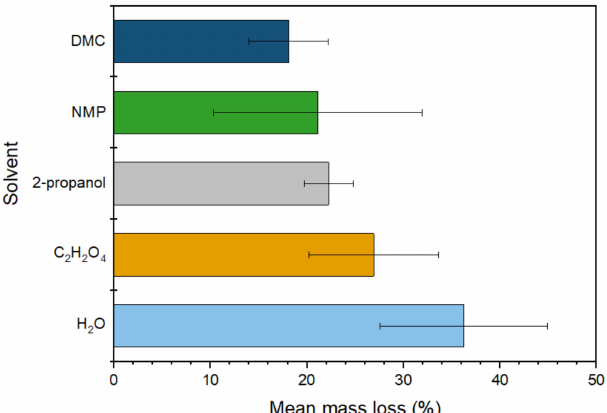
Figure 11. Mass loss of the separator on washing with various solvents (DMC, NMP, IPA, oxalic acid and